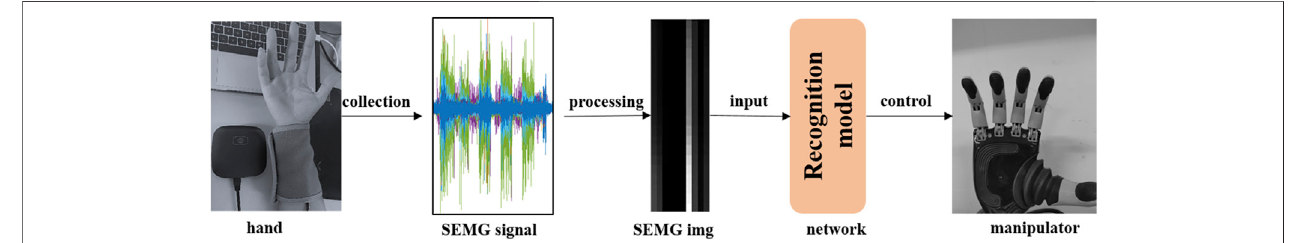
FIGURE 1 | Dexterous hand control process with sEMG